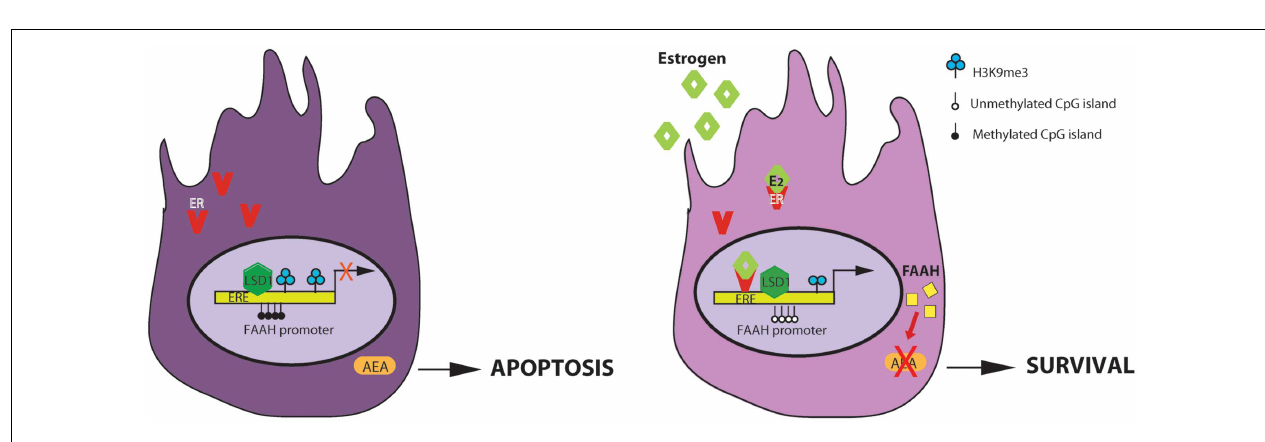
the right: estrogens activates the AEA-degrading enzyme FAAH transcription, through ER binding at ERE sites and reduction of DNA and H3K9me3 methylation.The direct/indirect interaction with histone demethylase LSD1, constitutively recruited at this site, is necessary for estrogen-induced transcription.The final outcome is a decrease of AEA-induced apoptosis of Sertoli cells (ERE, estrogen response